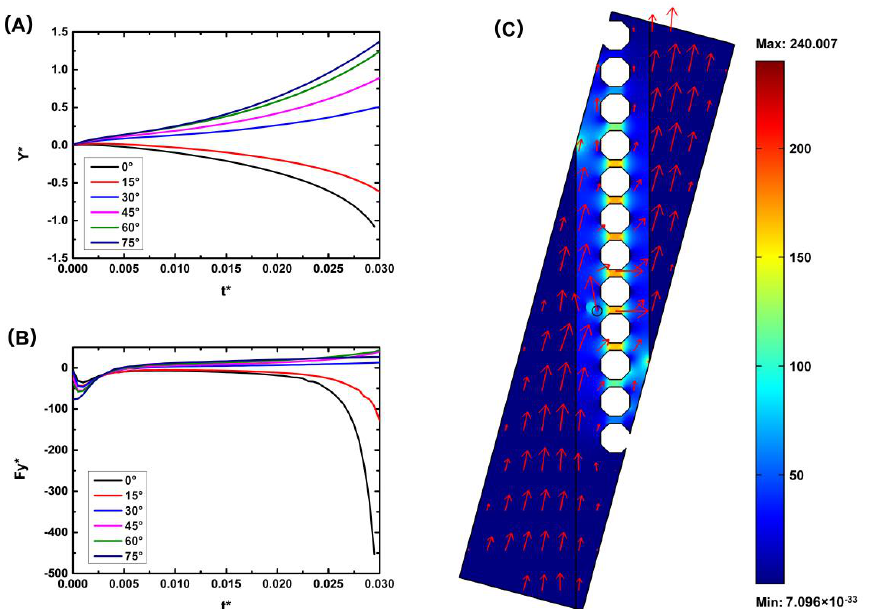
Figure 3. Distribution of the electric field and the movement of different size particles on a microfilter and negative dielectrophoresis combined chip. Arrows represent the direction of the flow field.